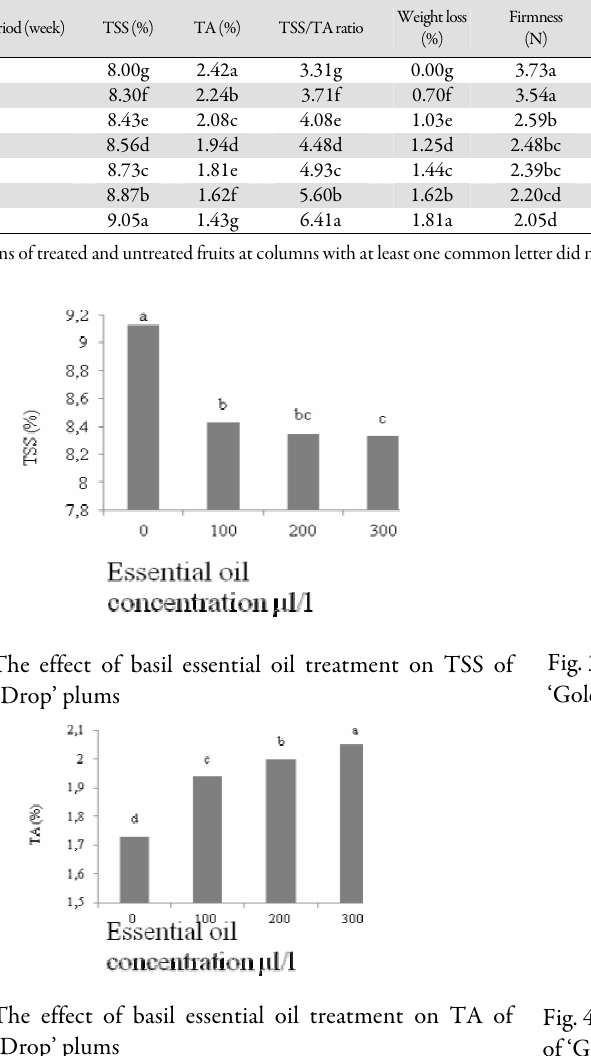
Tab. 1. Chemical composition of the O. basilicum essential oil Treatment